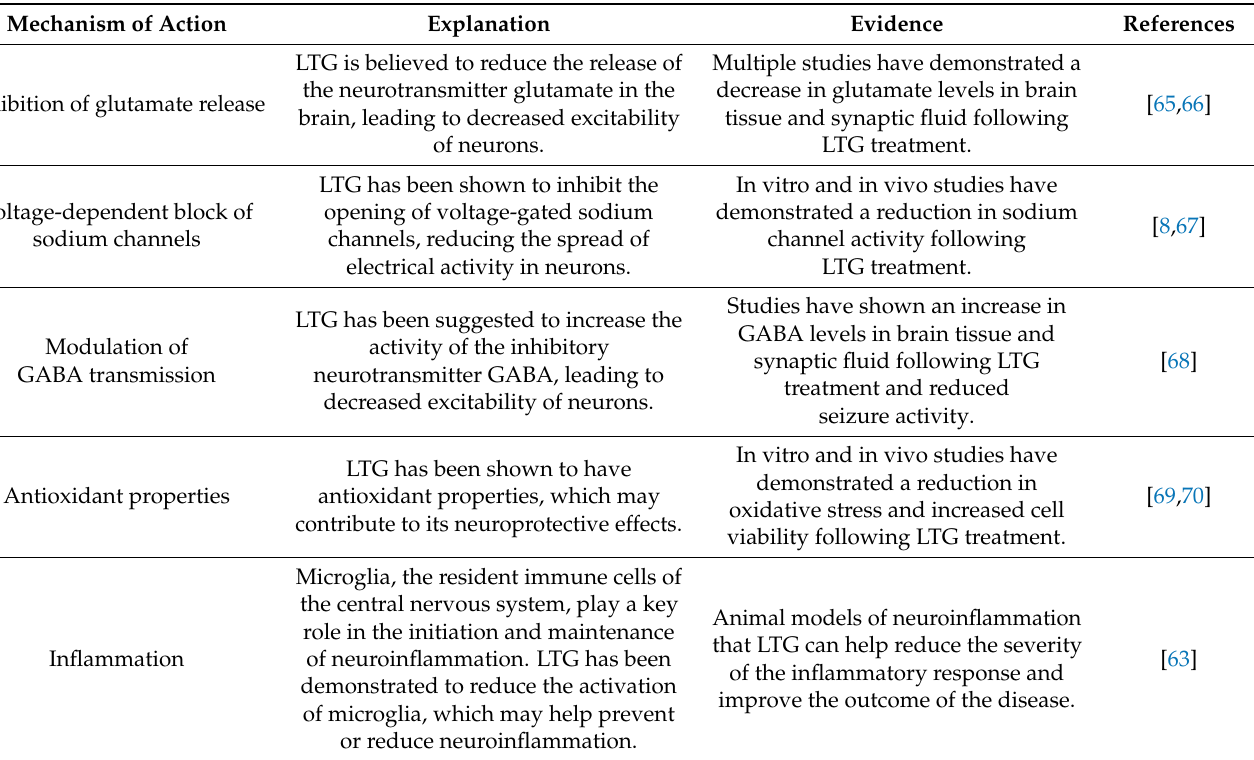
Table 2. Known mechanisms of LTG